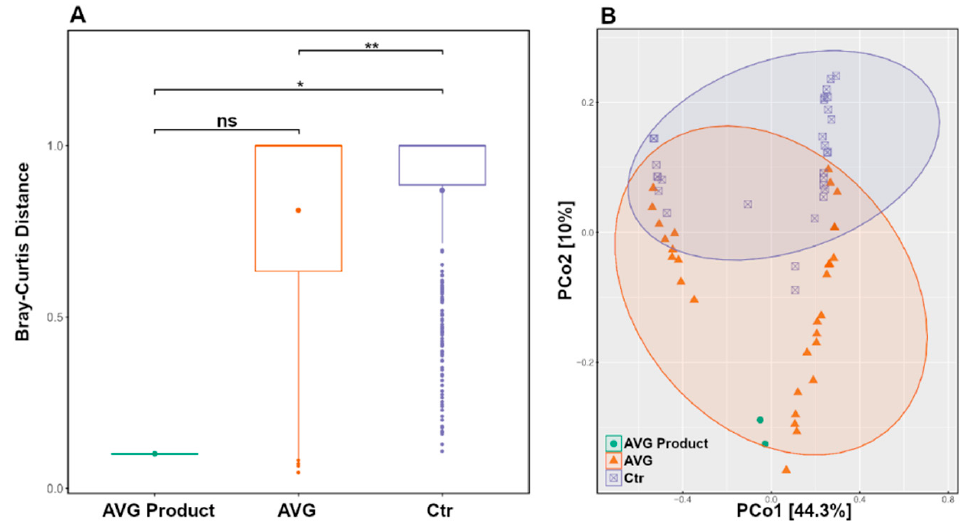
Figure 5. PERMANOVA boxplot (Panel ( A )) and Unweighted UniFrac PCoA plot (Panel ( B )) on caecal microbiota subset. (ns = not significant, ** p < 0.01; * p < 0.05). While the rest of the data in this manuscript was presented at an OTU level, this data was analysed at an ASV level.